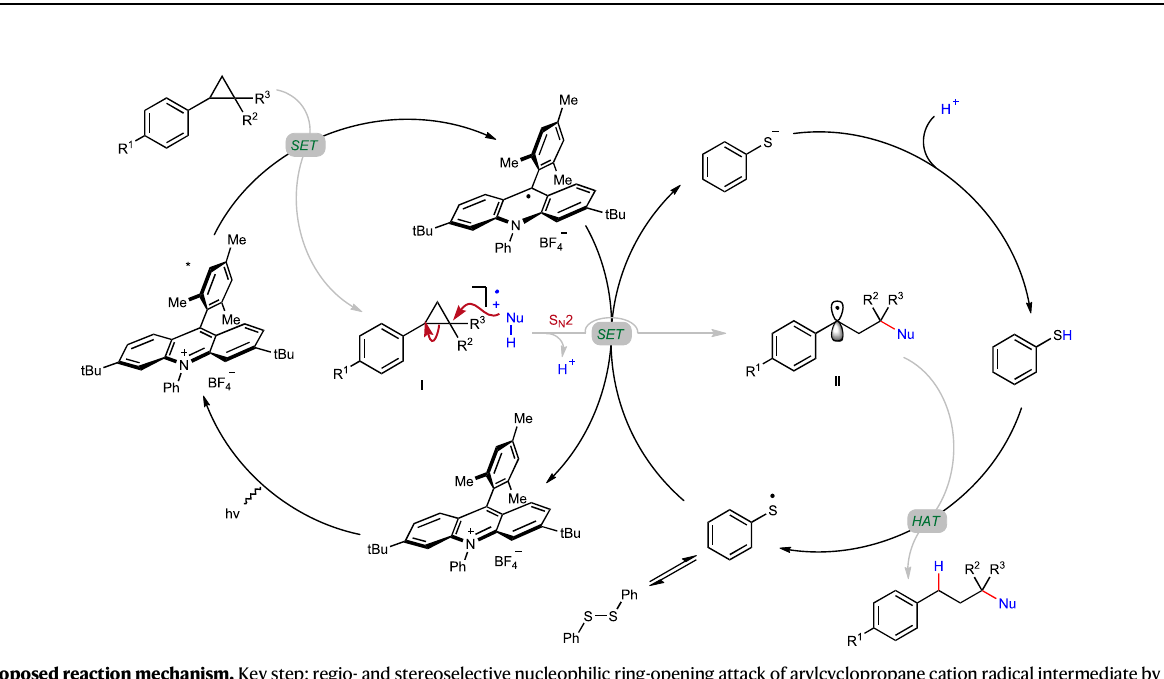
Fig.9|Proposedreactionmechanism. Keystep:regio-and stereoselectivenucleophilicring-openingattackofarylcyclopropanecationradicalintermediatebyexternal hetero-nucleophile for sterically congested C( sp 3 ) – heteroatom bond